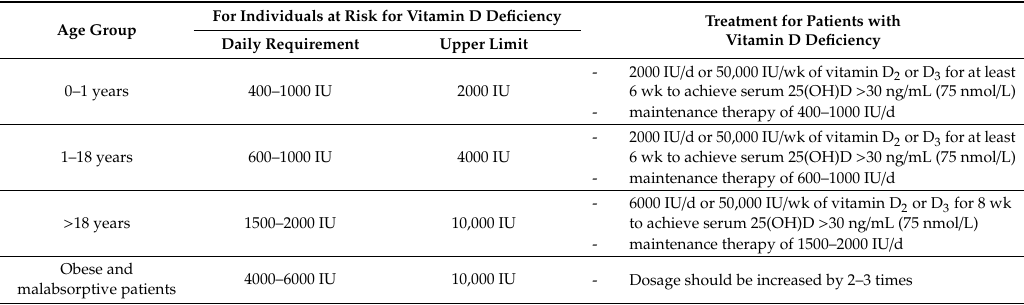
Table 1. The recommended dosage for vitamin D intake in individuals who are at risk for vitamin D deficiency and dosage of vitamin therapy treatment for patients with vitamin D deficiency. For Individuals at Risk for Vitamin D Deficiency Treatment for Patients with Age Group